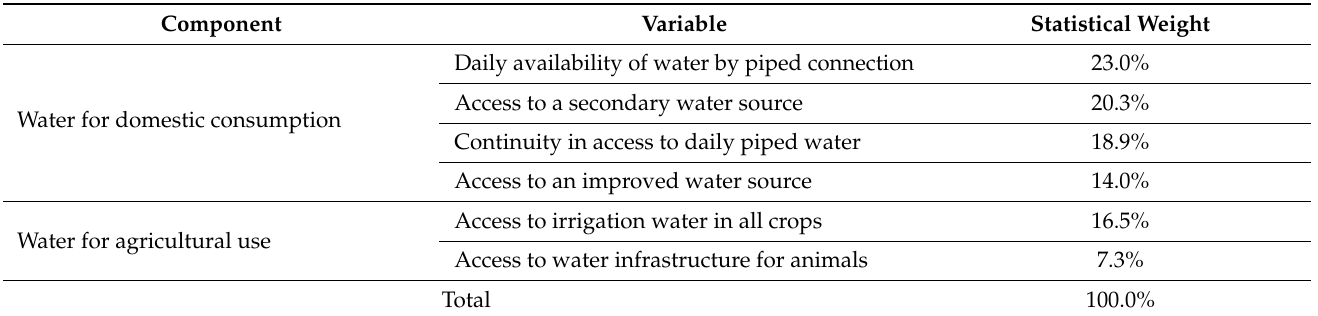
Table 7. Water Index for rural communities.